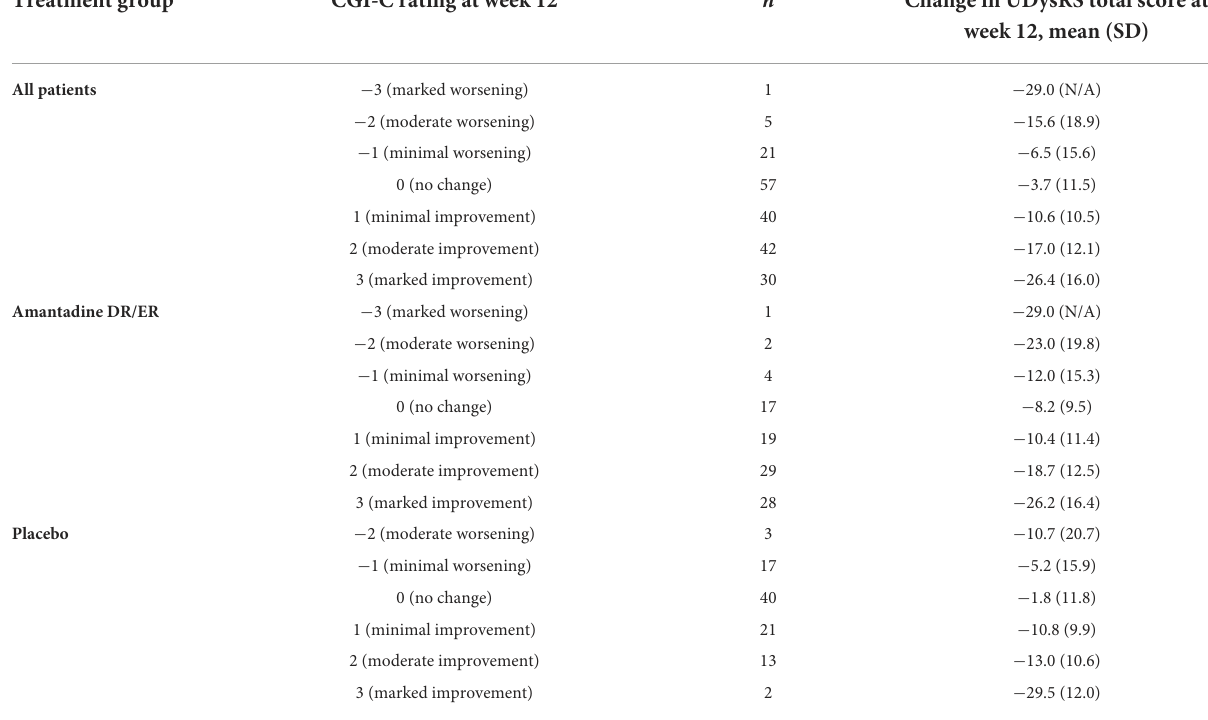
Scorechangesarefrombaselinetoweek12(usingLOCF).Numberofparticipantswithnopostbaselinediary: a n DR,delayed-release;ER,extended-release;LOCF,lastobservationcarriedforward;SD,standarddeviation;UDysRS,UnifiedDyskinesiaRatingScale. TABLE 4 Mean changes in the UDysRS total score for each category of CGI-C rating. Treatment group CGI-C rating at week 12 n Change in UDysRS total score at